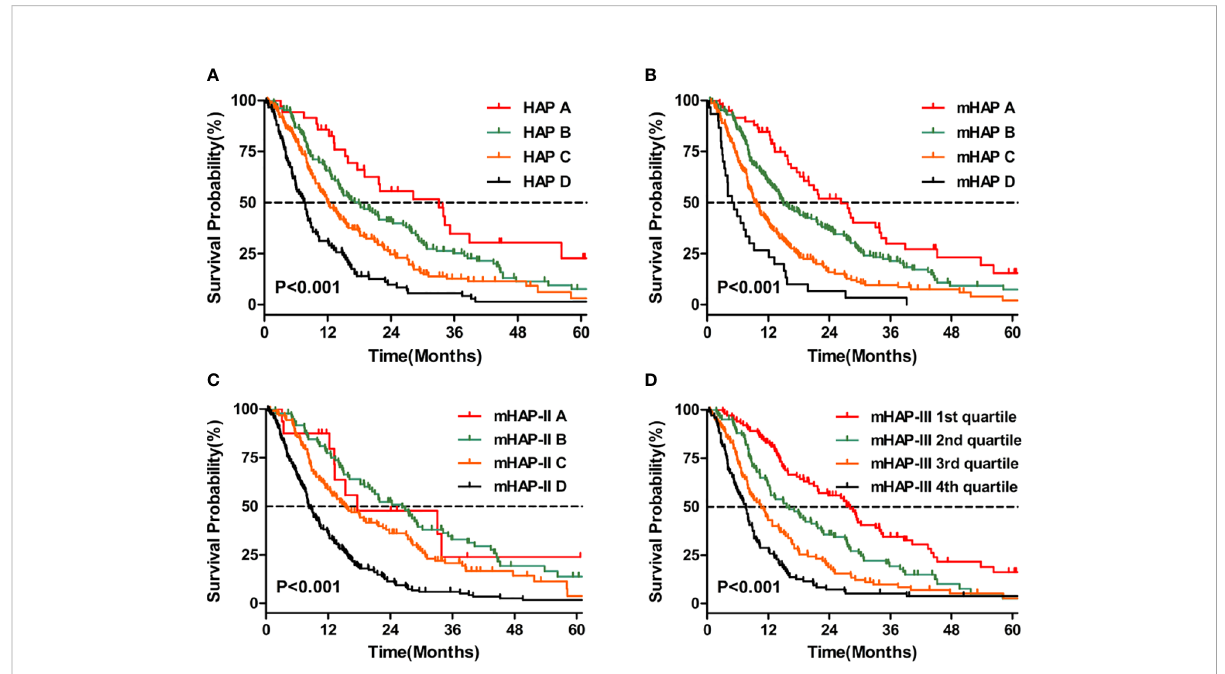
FIGURE 3 Kaplan – Meier curves for OS. (A) Comparison of survival between patients with HAP A, HAP B, HAP C, and HAP D (B) Comparison of survival between patients with mHAP A, mHAP B, mHAP C, and mHAP D (C) Comparison of survival between patients with mHAP-II A, mHAP-II B, mHAP-II C, and mHAP-II D (D) Comparison of survival between patients with mHAP-III (1st quartile, 2nd quartile, 3rd quartile, and 4th quartile). HAP, hepatoma arterial-embolization prognostic; mHAP, modi fi ed hepatoma arterial-embolization prognostic; OS, overall